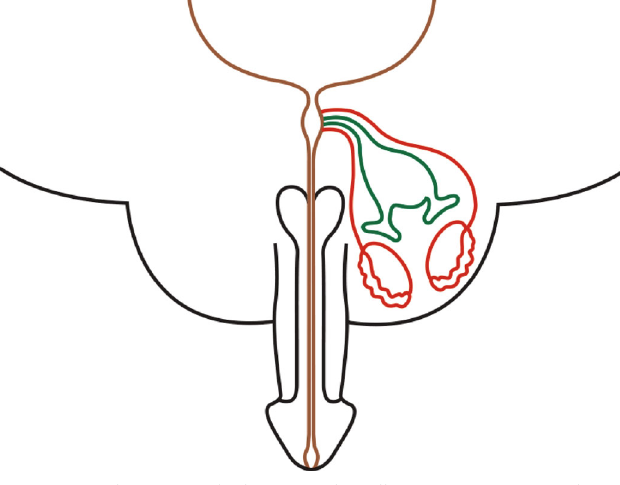
Figure 4: Three described anatomical variants of PMDS. Key: red: Wol ffi an structures plus testes; green: persistent Müllerian structures; brown: bladder and